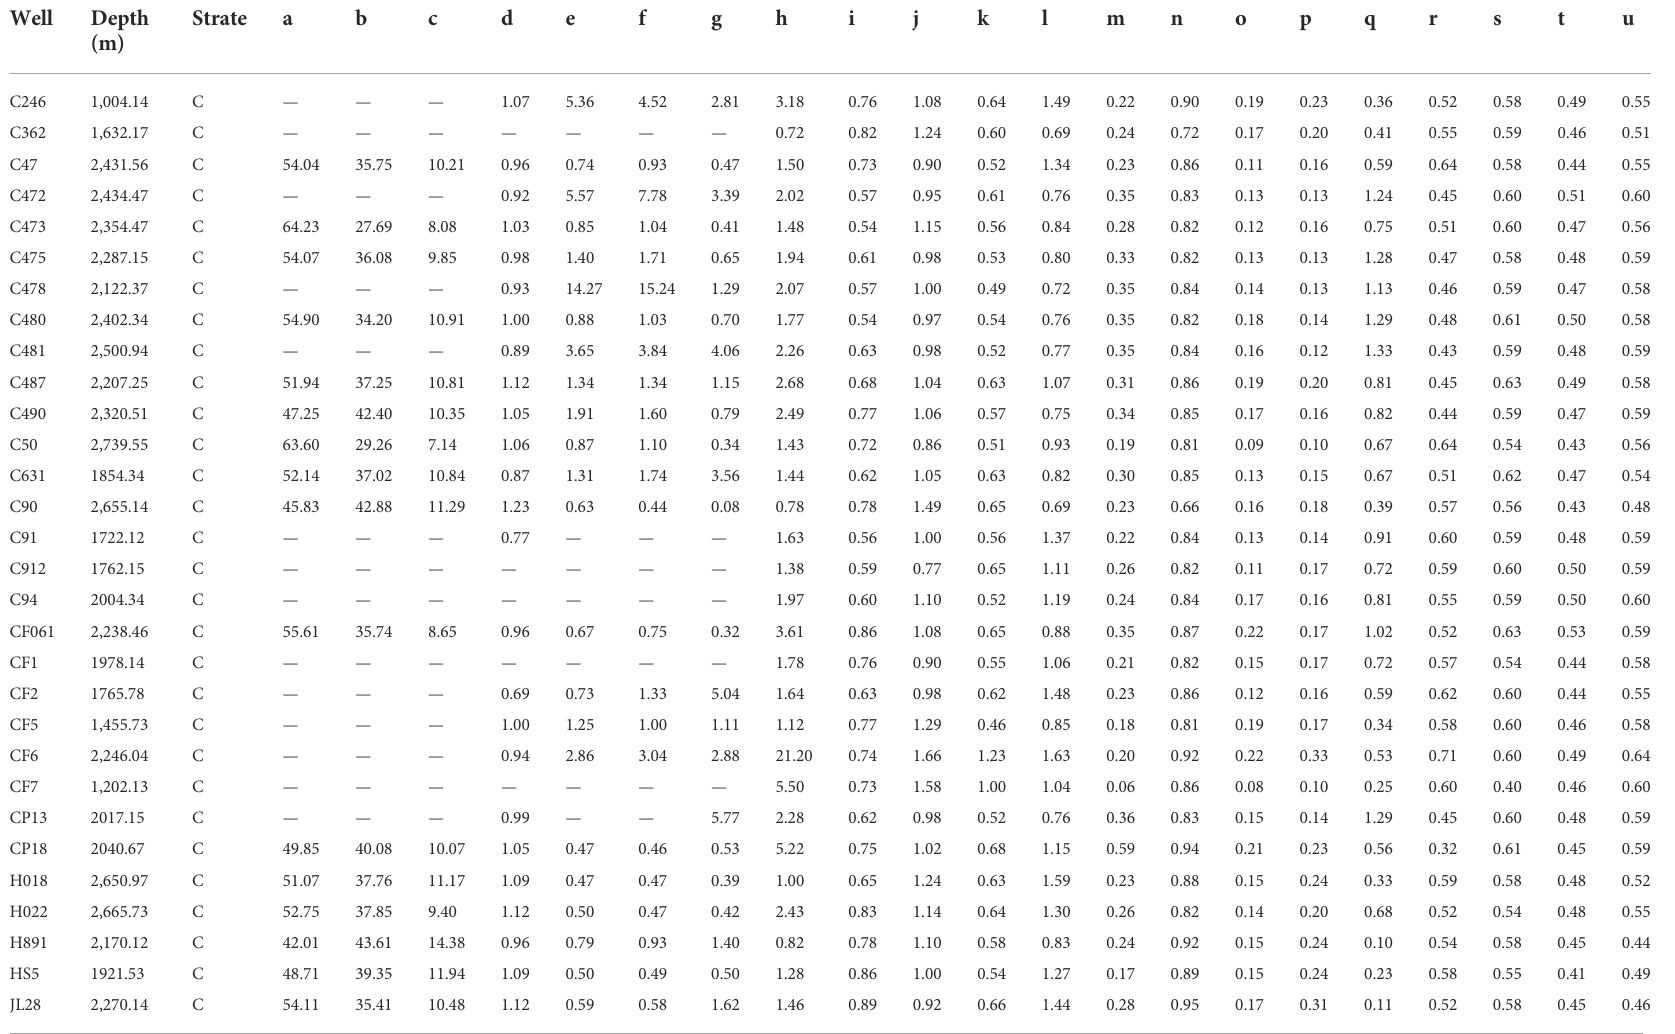
TABLE 3 Biomarker parameters from the analyzed crude oil samples in the Hongche fault zone.